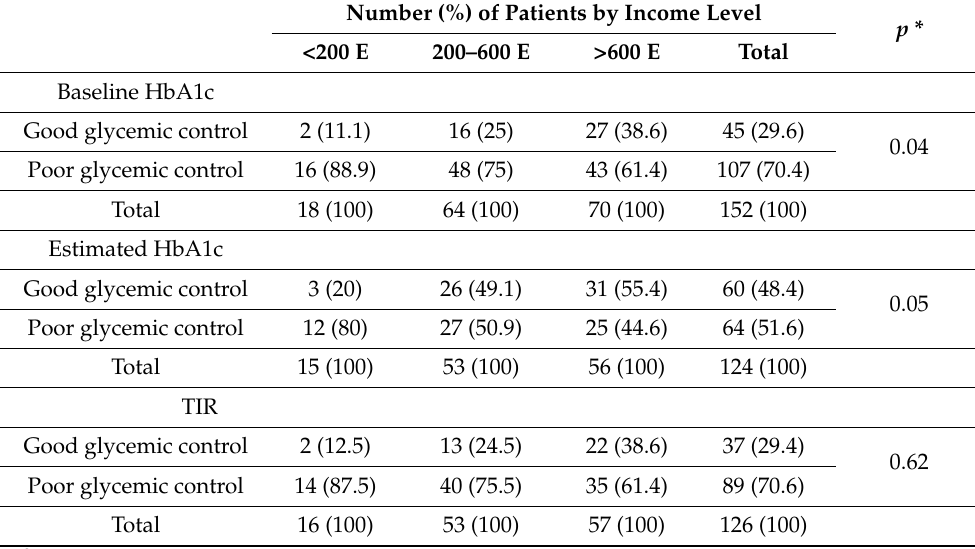
Table 6. Differences in glycemic control among income groups.